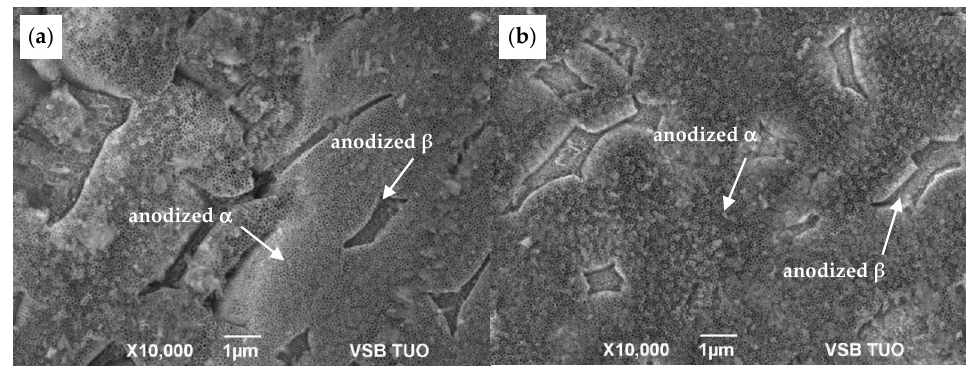
Figure 5. SEM SEI images of the surfaces anodized-heat treated: ( a ) ground and ( b ) polished.